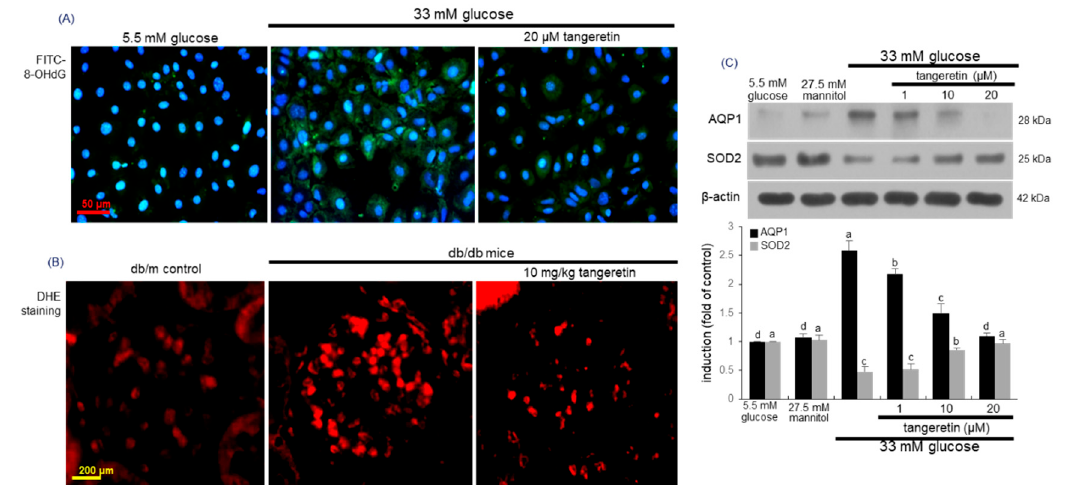
Figure 5. Blockade of 8-OHdG induction ( A ), reactive oxygen species (ROS) production ( B ) and AQP-1 induction ( C ) and elevation of SOD2 induction ( C ) by tangeretin in glucose-exposed podocytes and in diabetic kidneys. Podocytes were incubated in media containing 5.5 mM glucose, 5.5 mM glucose plus 27.5 mM mannitol as osmotic controls or 33 mM glucose in the absence and presence of 1–20 μ M tangeretin for 4 days. For the immunocytochemical analysis of 8-OHdG ( A ), a FITC-conjugated secondary antibody was used to visualize the induction of 8-OHdG. The nuclear staining was done with DAPI (blue). Each photograph is representative of stained cells. Magnification: 400-fold. The db/db mice were orally supplemented with 10 mg/kg tangeretin for 10 weeks. For the measurement of ROS generation in kidney glomeruli, the dihydroethidium (DHE) staining was performed ( B ). Each photograph is representative of four mice. Scale bar = 50 μ m or 200 μ m. Cell lysates and tissue extracts were electrophoresed on 12%–15% SDS-PAGE and subject to Western blot analysis with a primary antibody against AQP-1 and SOD2 ( C ). β -Actin antibody was used as an internal control. The bar graphs (mean ± SEM, n = 3) represent quantitative results of blot bands obtained from a densitometer. Values in bar graphs not sharing a common letter are significantly different at p < 0.05.